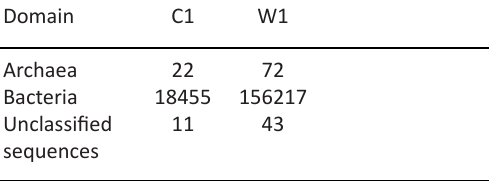
Table 3. Taxa Statistics at Domain level Table 2. The correlation between Illumina 1.8 base